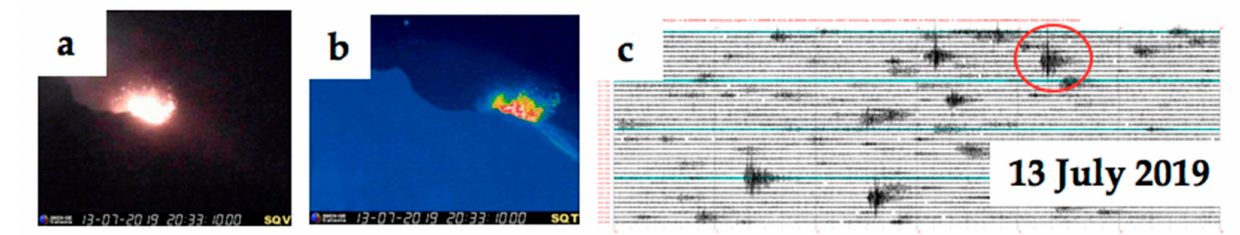
Figure 5. ( a ) Visual image from the SQV camera of the 13 July 2019 event at 20:33:10, view from NE with ( b ) corresponding thermal image taken from the SQT camera at 20:33:10. Blue is cold, white is hot. ( c ) Seismic trace with the red circle evidencing the explosive event displayed in the images above. See Figure 1 for station locations.